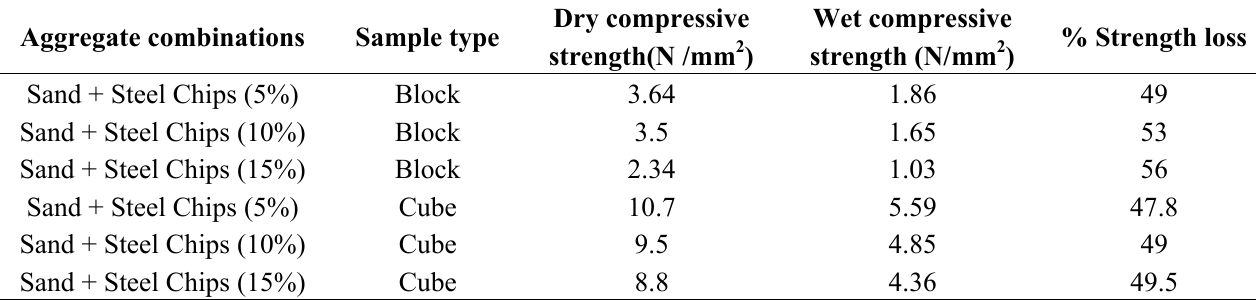
Table 4. Compressive strength loss due to wet compressive strength